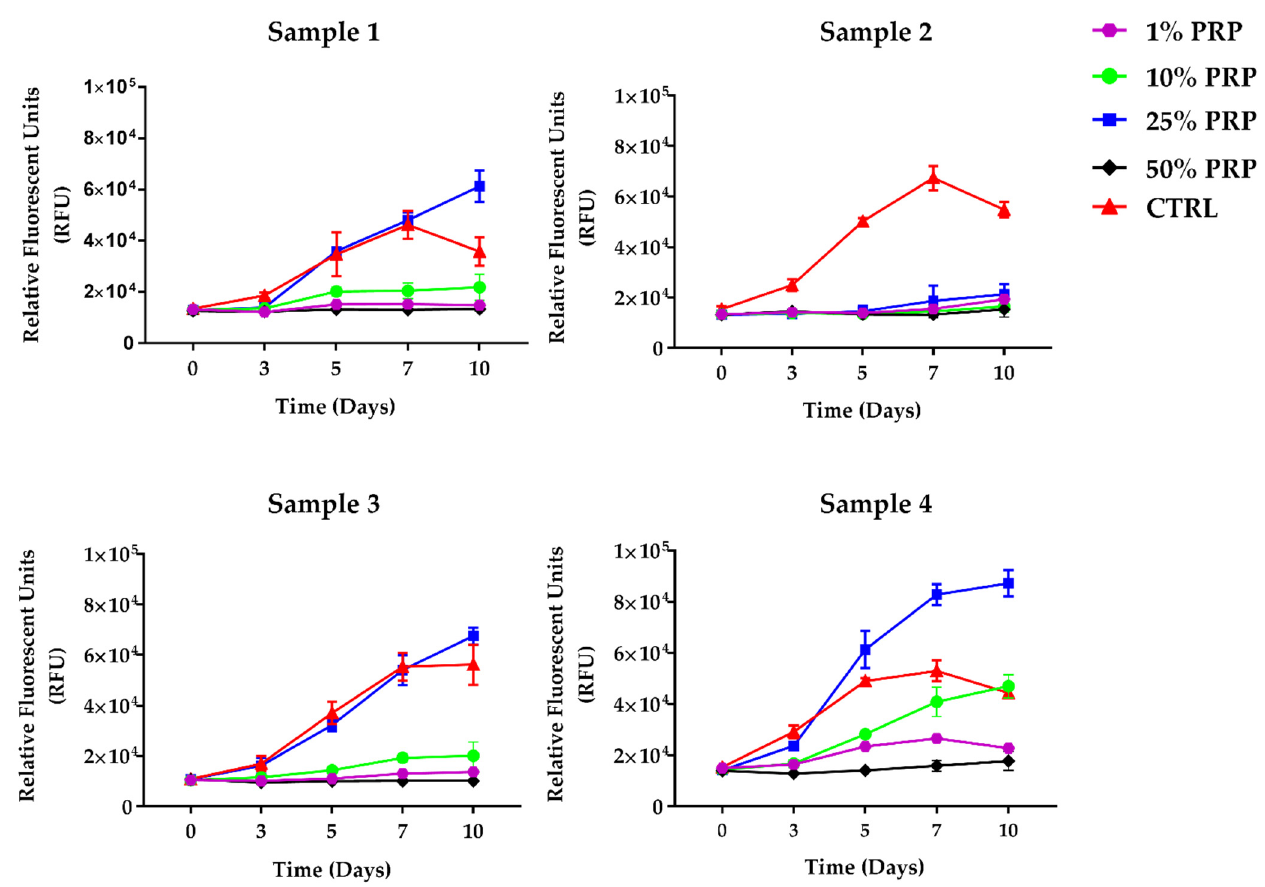
Figure 3. Growth curves of HOB-01-C1 cells treated with different PRP dilutions, obtained by Resazurin assay: cells seeded in complete medium containing 10% HSAB (Positive control, red curve); 1% PRP (magenta); 10% PRP (green); 25% PRP (blue), and 50% PRP (black). The X -axis reports the days of culture, whereas the Y -axis reports the relative fluorescence units (RFU). Data are expressed as mean ± SD of three independent experiments.